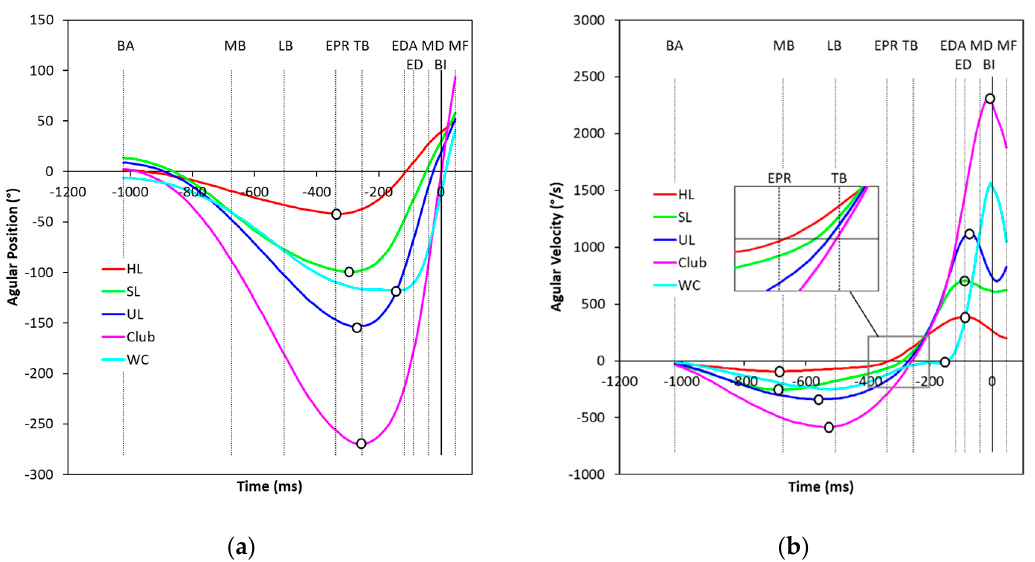
Figure 2. Ensemble-average on-plane angular position ( a ) and angular velocity ( b ) patterns of the axle-chain system (driver; n = 66). Transition points and angular velocity peaks (backswing and downswing) are marked. Negative angular positions mean backward-rotated or cocked. Abbreviations: HL—hip line, SL—shoulder line, UL—upper lever, and WC—wrist cock angle.